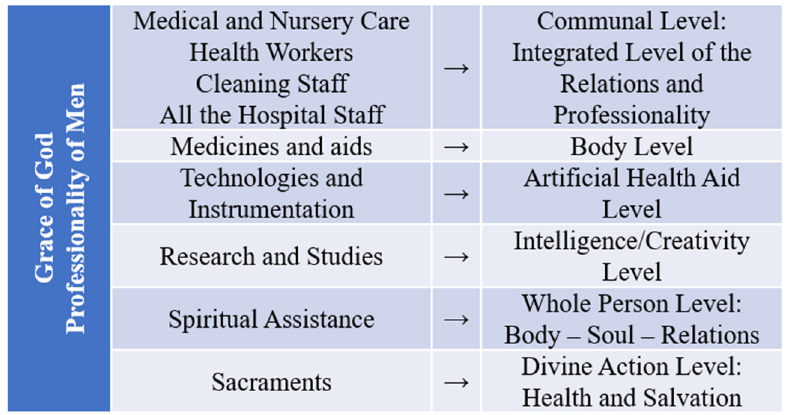
Figure 1. Multiple level extension of the care approach.